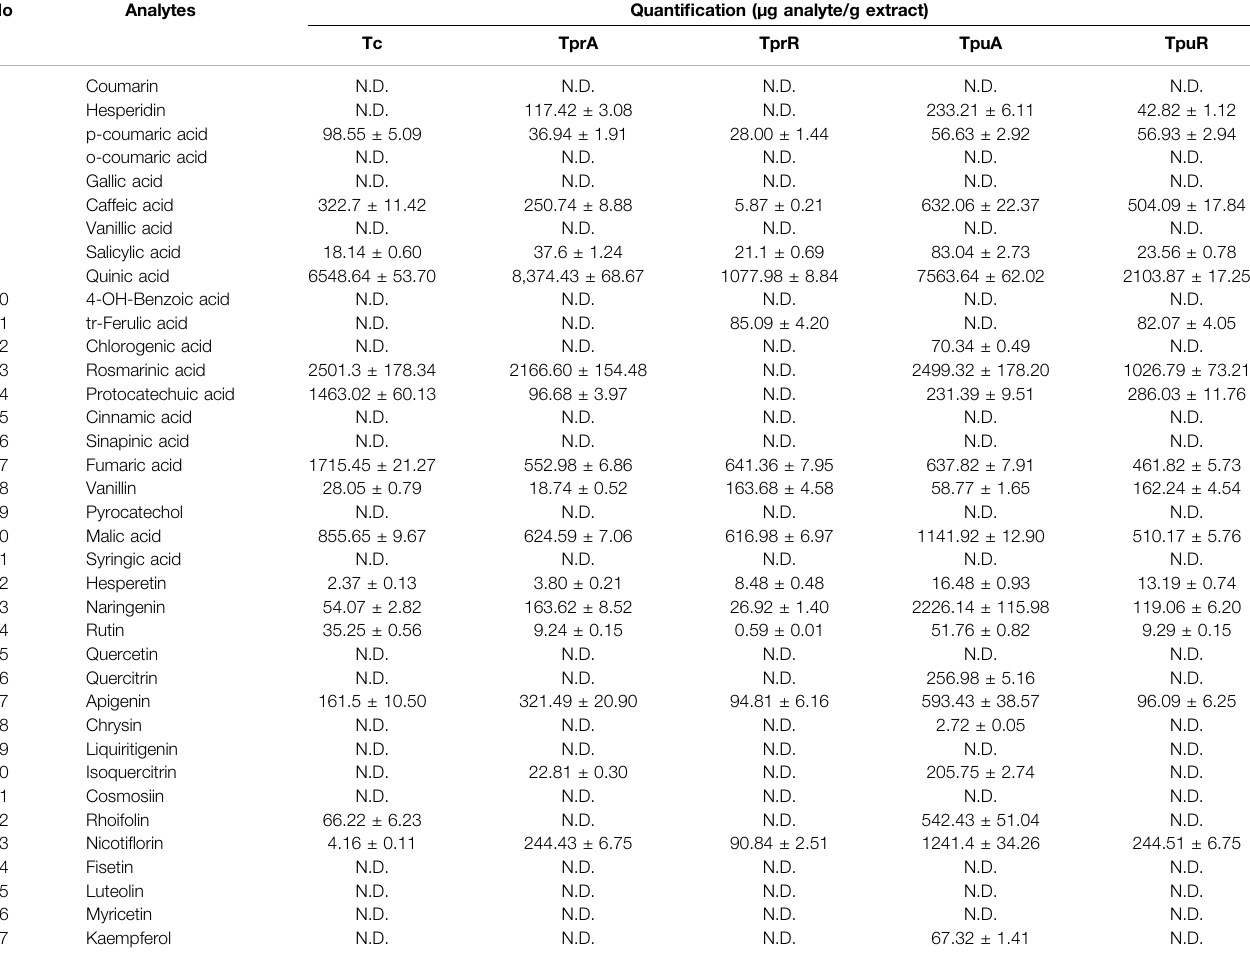
TABLE 2 | LC-MS/MS results of the studied Thymus